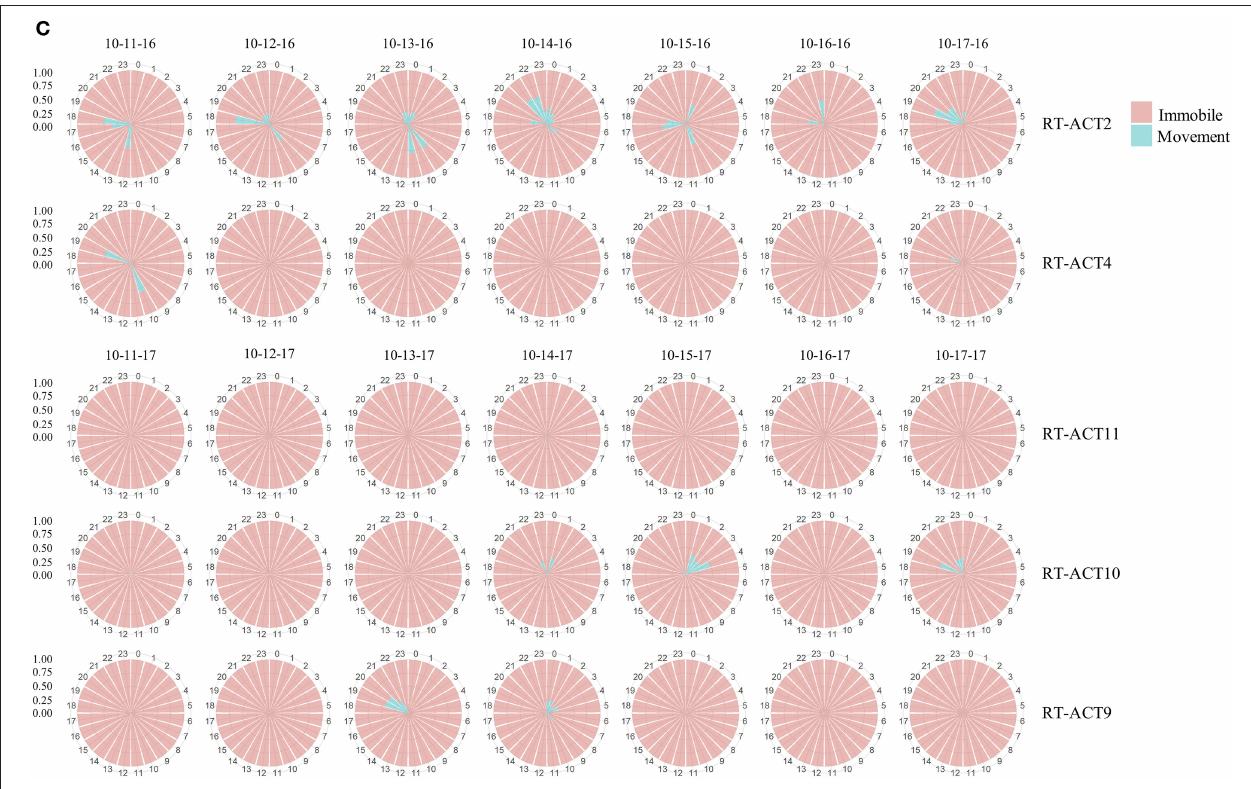
FIGURE 3 | Radial histograms depicting activity budgets (time classified as movement vs. immobile) at monthly (A,B) and daily scales (C) for male Crotalus atrox monitored during October 2016 and 2017. Proportions are derived from classifications made by the optimized RF model. Individual bars correspond to a single hour within a 24h period. The aggregated plot (A) depicts the mean activity budget for all rattlesnakes monitored during October ( N depict the mean daily activity budgets for each of the five C. atrox that contributed data across every day of October ( N proportion of time spent moving (blue) or immobile (pink) within each hour of individual days during the week of October 11–October 17 (2016 or 2017). October was selected for visualization because it had the largest concurrent ACT monitoring sample size among the active season months (Apr–Oct) during the study. Note that although periods of movement are highly infrequent and often temporally dispersed between extensive periods of immobility, there is considerable snake-to-snake variation in